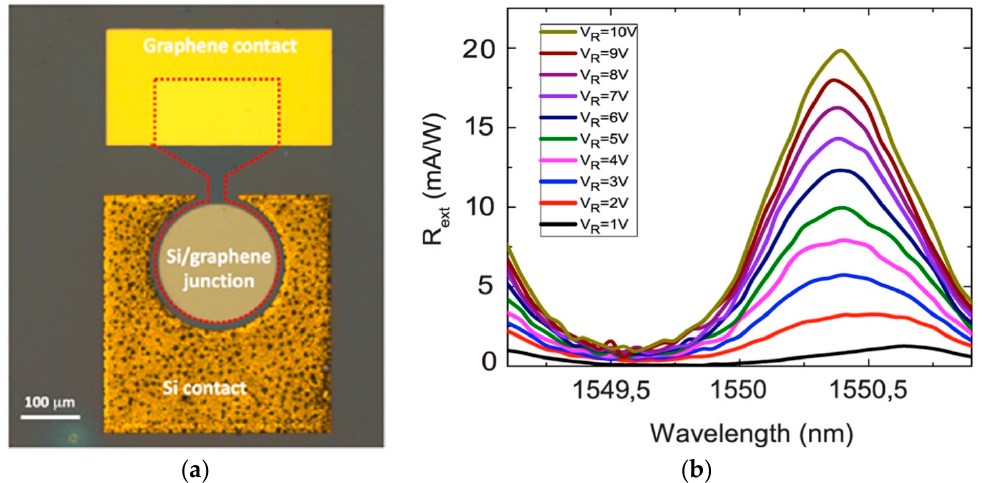
Figure 6. ( a ) Optical image of fabricated device investigated in Casalino [38]. ( b ) Responsivity vs reverse voltage. Reprinted with permission from (Casalino, Sassi, Goykhman, Eiden, Lidorikis, Milana, De Fazio, Tomarchio, Iodice, Coppola et al. Vertically Illuminated, Resonant Cavity Enhanced, Graphene-Silicon Schottky Photodetectors. ACS Nano 2017 , 11 , 10955–10963). Copyright (2017) American Chemical Society.